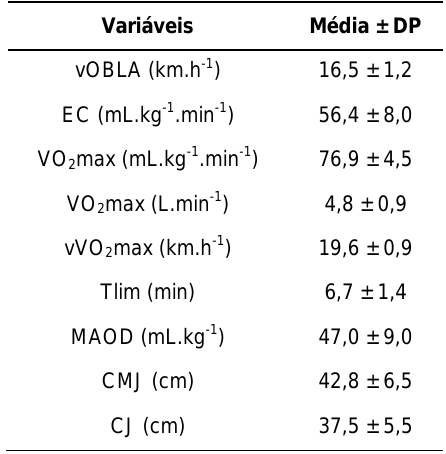
Tabela 1. Valores descritivos das variáveis fisiológicas e neuromusculares dos atletas. Variáveis